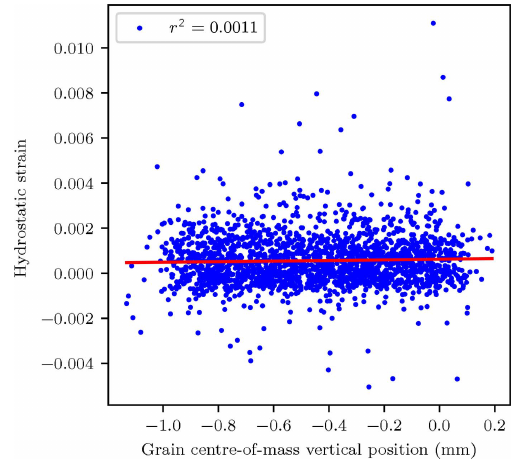
Figure 7 Plot of hydrostatic lattice distortion (hydrostatic strain) variation with grain centre-of-mass vertical